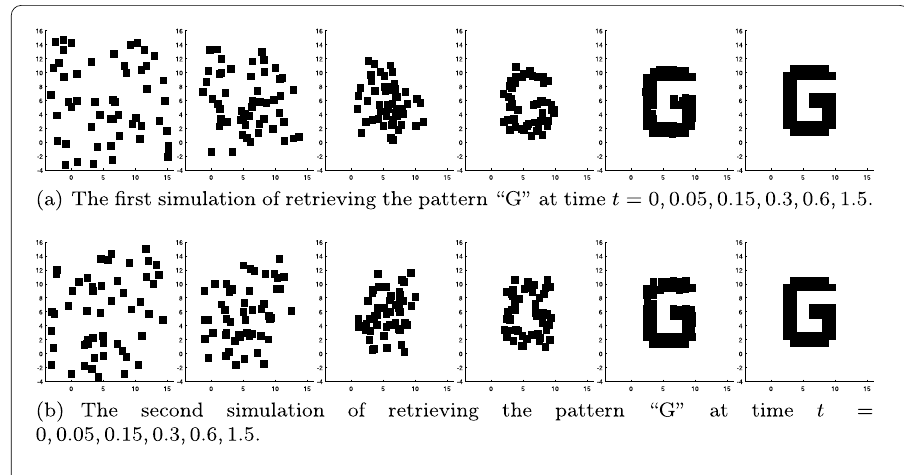
Figure 4 Two simulations of retrieving the pattern “G” with random initial